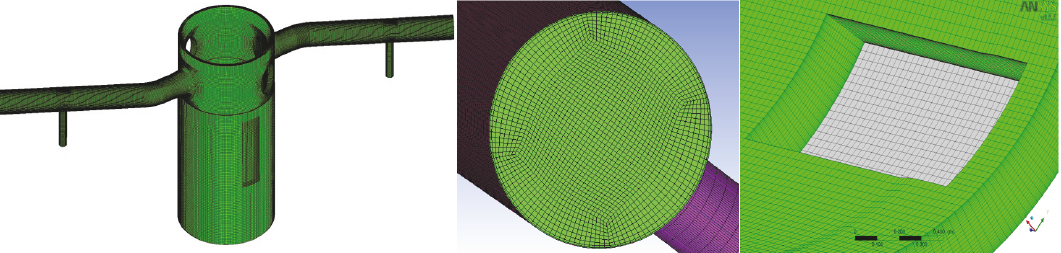
Figure 7: Grid of the main pipes and upper section of downcomer.